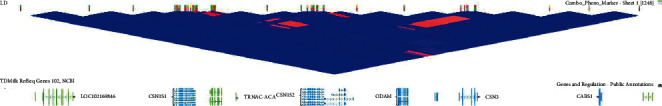
Identification of genomic coordinates (Combo_Pheno_Marker) using a portion of a heat map associated with TDMilk in comparison to RefSeq genes in National Center for Biotechnology Information (NCBI). The chromosomes of Capra hircus were used to for association with known sequences of SNPs. LOC102169846 is associated with estrogen sulfotransferase. CSN1S1 is associated with casein alpha s1. ODAM is an ameloblast associated with a processed peptide: odontogenic ameloblast-associated protein. CABS1 is associated with a calcium-binding protein. These and many more associated SNPs identified by this study are found in the NCBI repository.